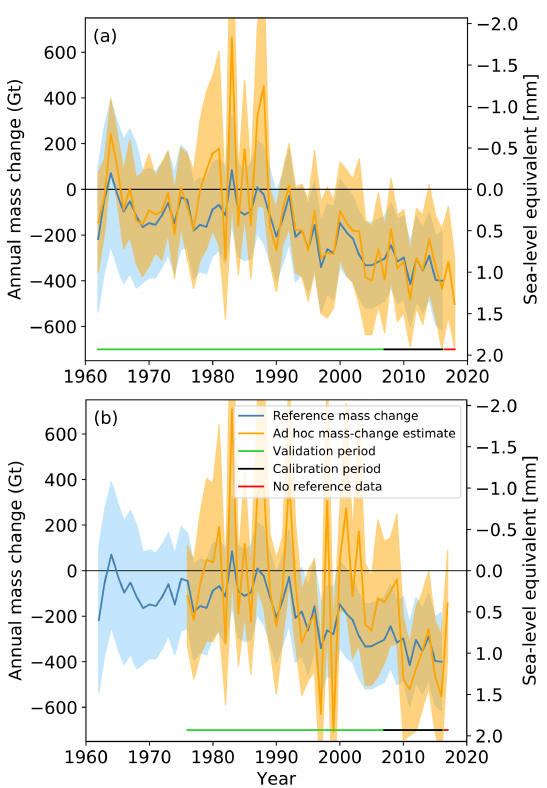
Figure 2. Global glacier contributions to sea-level rise from 1961/62 to 2017/18. (a) Full glaciological sample: annual mass changes (left y axis) and global sea-level equivalents (right y axis) are shown with related error bars (indicated by shadings) corre- sponding to 95% confidence intervals. The ad hoc estimates (or- ange), based on the full glaciological samples of corresponding years, are shown with annual values of the reference dataset (blue) by Zemp et al. (2019), which was used for calibration. The bottom line indicates the time periods used for calibration (black), valida- tion (green), and without reference data (red). (b) Reference glacier sample: same plot but for ad hoc estimates (orange) solely based on glaciological data from the 41 WGMS reference glaciers (with more than 30 years of ongoing measurements). Due to limited data coverage, no ad hoc estimates were possible for 2017/18 and be- fore